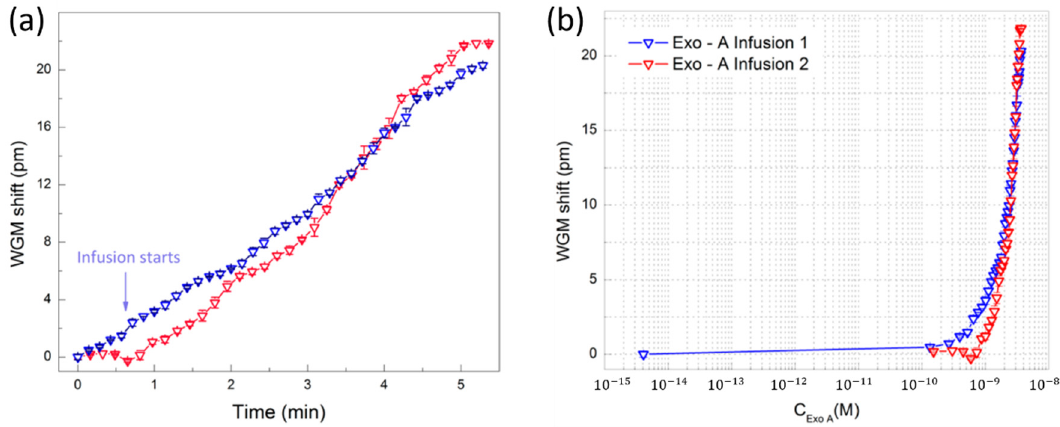
Figure 27. ( a ) Real-time responses of 2 different α -Exotoxin A conjugated microtoroid batches to Exotoxin A infusions in artificial sputum. ( b ) Wavelength shifts as a function of increased Exotoxin A concentration in artificial sputum. Adapted from ref. [140] with permission from ACS Publications.